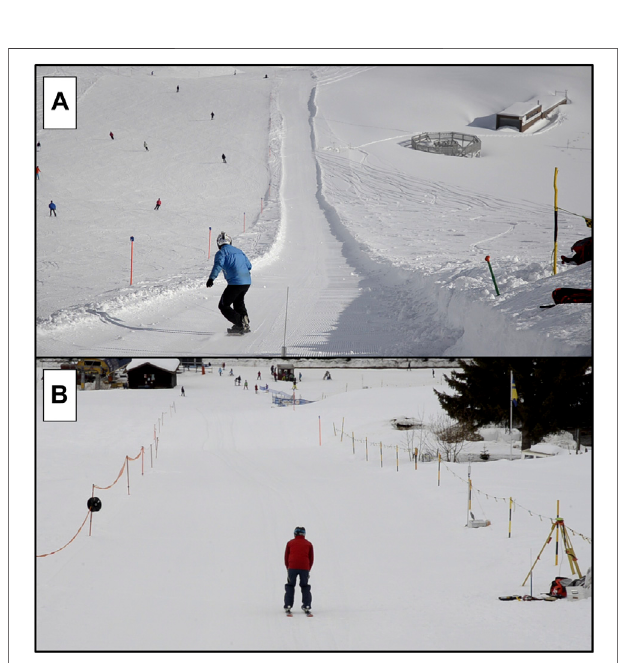
FIGURE 2 | Gliding tracks at Davos Weiss fl uhjoch (A) and Bolgen (B) with a skier and a snowboarder holding the de fi ned mid-extended posture. Side view photographs of this posture were shown in Wolfsperger et al. (2021).